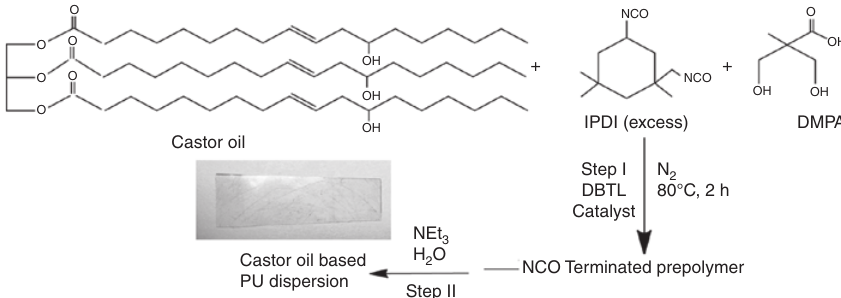
Figure 1: Reaction scheme for the synthesis of polyurethane (PU) prepolymer.